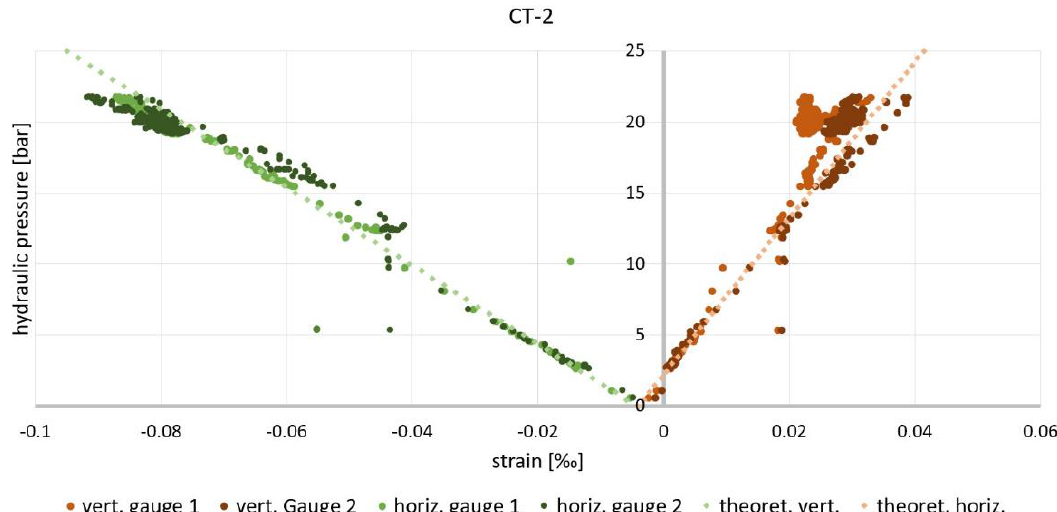
Figure 10. Comparison of the measured vertical and horizontal strain (test CT−2) against theoretical values ( 𝐸 𝑐 = 22,000 MPa, 𝜈 = 0.2 ).